Question: Is the quantity shown trending increasing or decreasing?
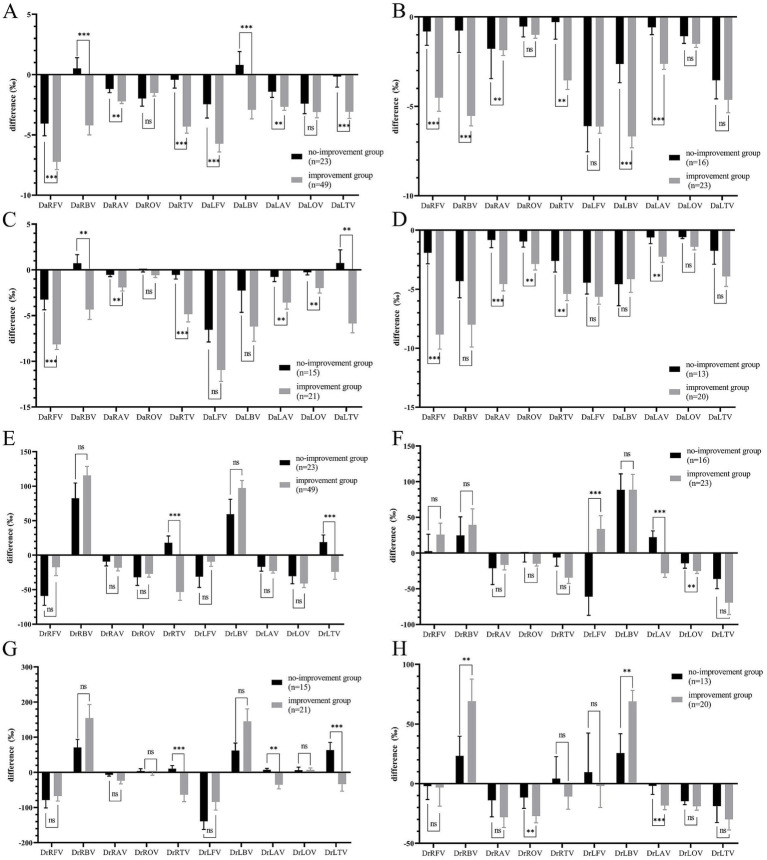
Answer: increasing